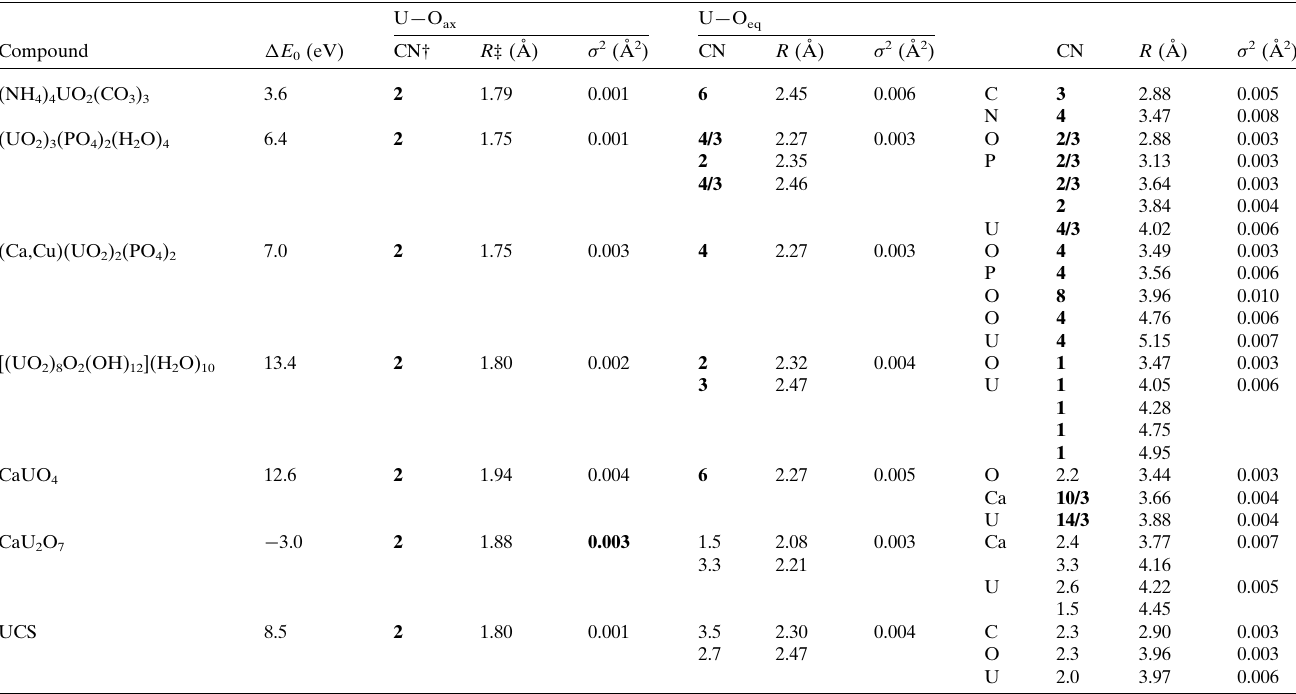
Table 1 Calculated interatomic distances, coordination numbers and Debye–Waller factors. Bold values were treated as fixed parameters during fitting.